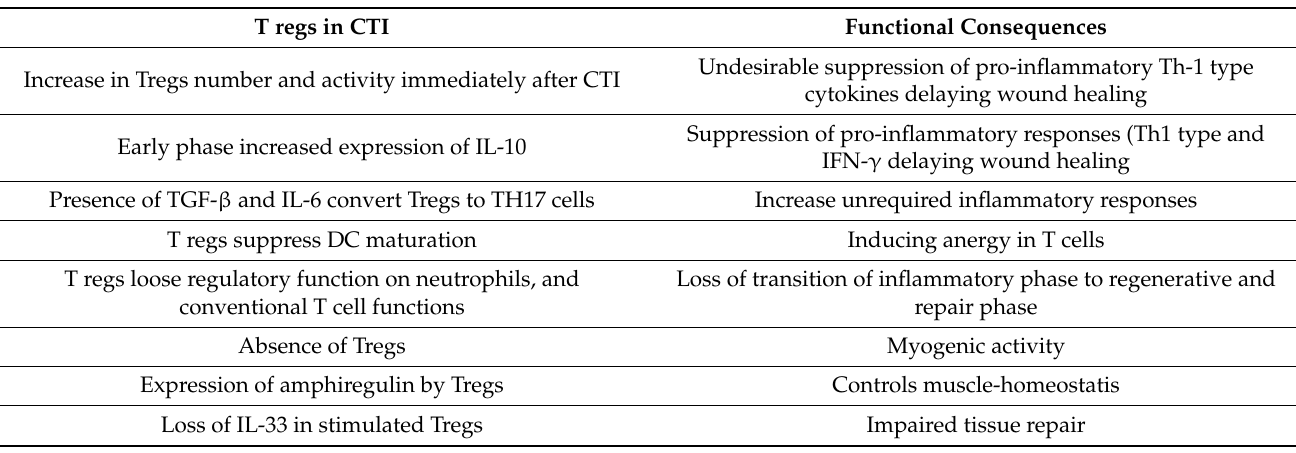
Table 2. T regs display both pro and anti-inflammatory responses in CTI during initial phases/immediately after trauma. T regs in CTI